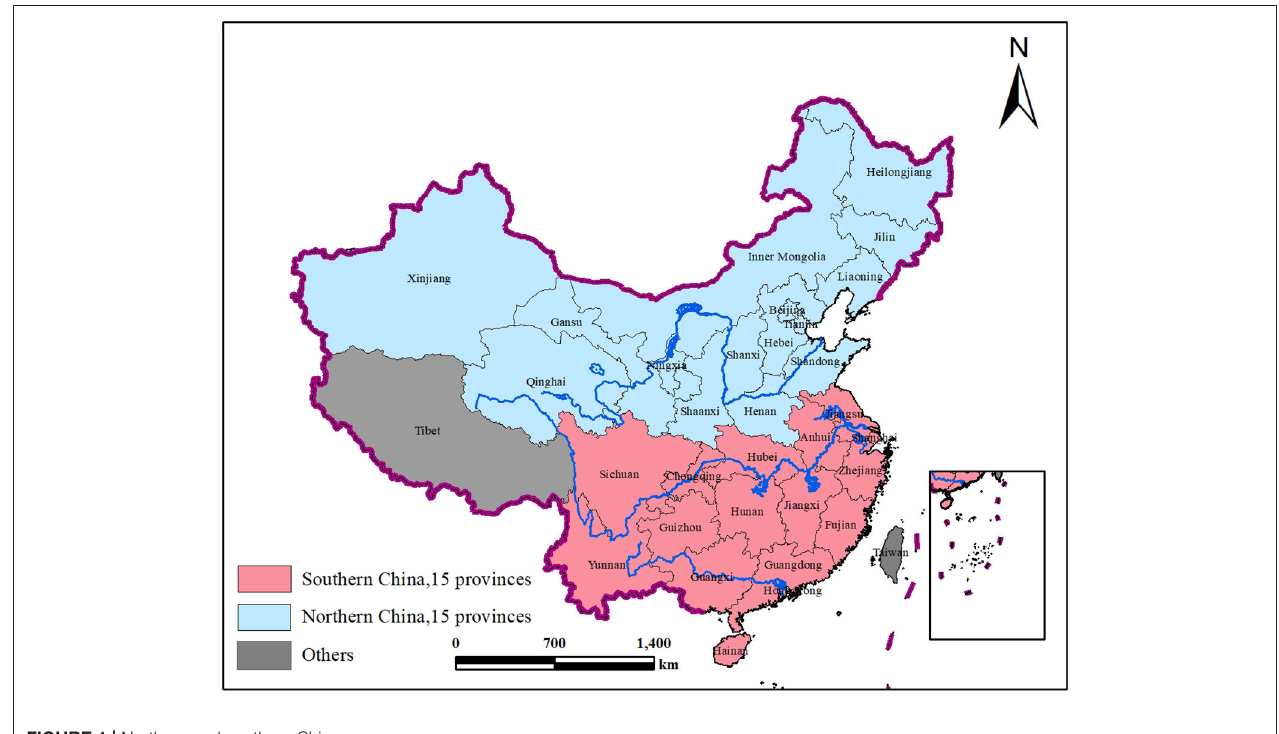
FIGURE 1 | Northern and southern China.